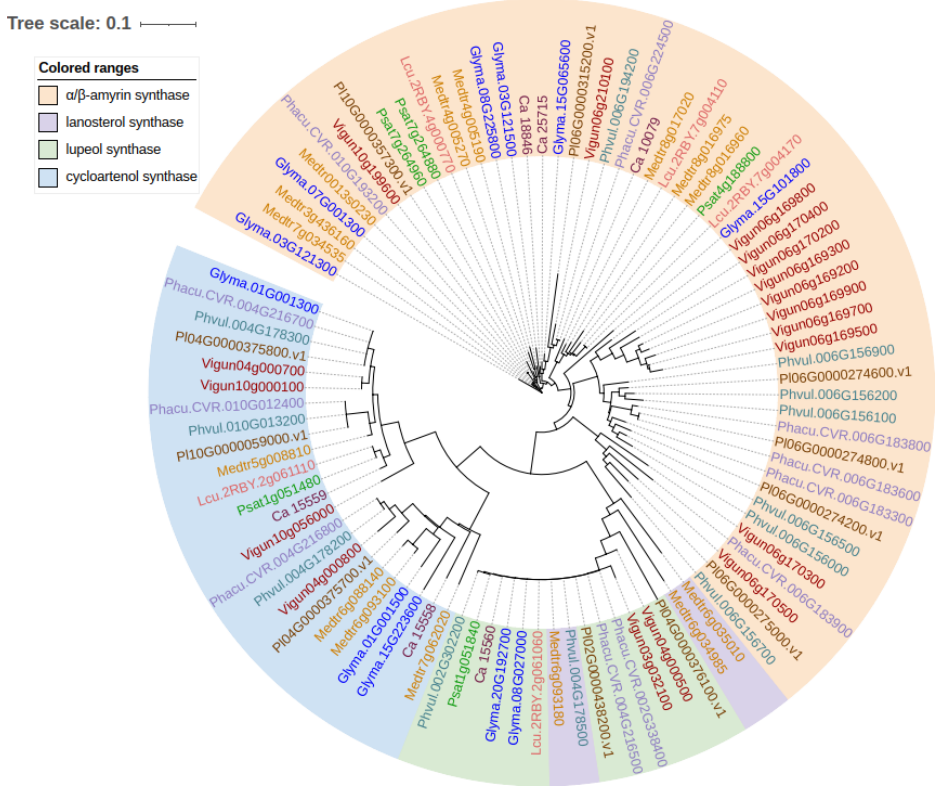
Figure 2. Neighbor-joining phylogenetic tree of oxidosqualene cyclases (OSCs) from pulse crop species. The amino acid sequences of pea ( Pisum Sativum ) OSCs were retrieved from the reference genome assembly of the cultivar Caméor (https://urgi.versailles.inra.fr/Species/Pisum/Pea-Genome-project, accessed on 6 December 2022). Pea OSCs were used for a blastp search against